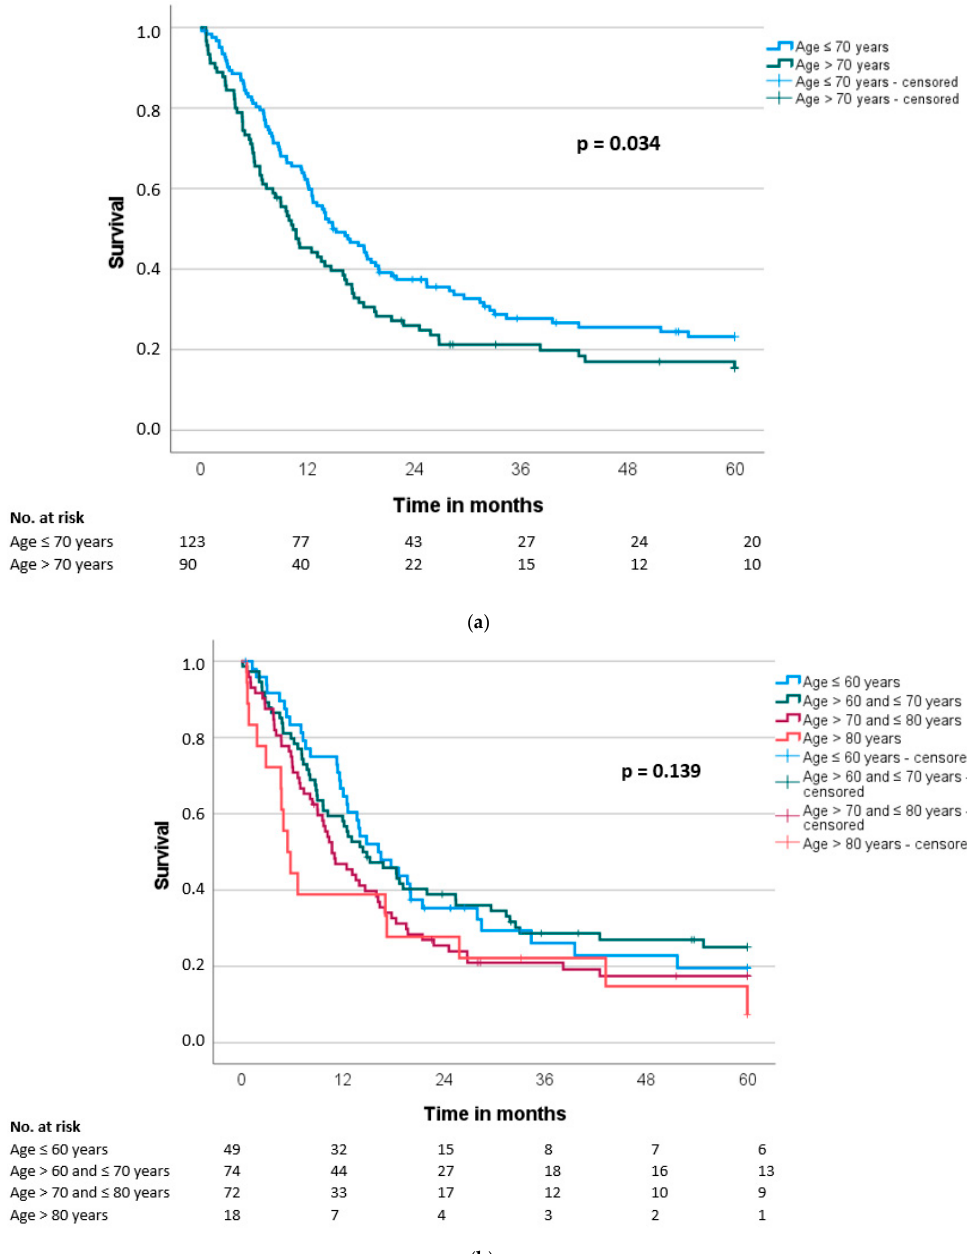
Figure 3. ( a ) Disease-free survival (DFS) according to patients’ age ( ≤ 70 vs. >70 years) ( n = 213). ( b ) Disease-free survival (DFS) according to patients’ age ( ≤ 60 vs. >60 and ≤ 70 vs. >70 and ≤ 80 vs. >80 years) ( n = 213).